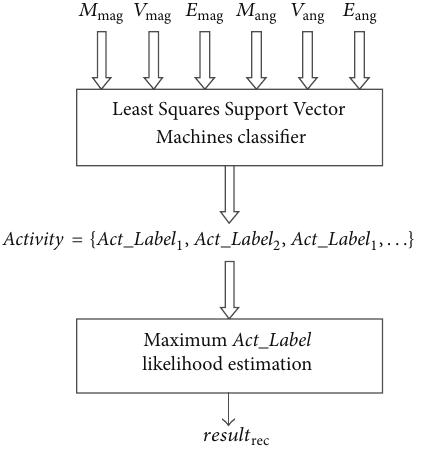
Figure 3: Activity estimator for multiclassification.